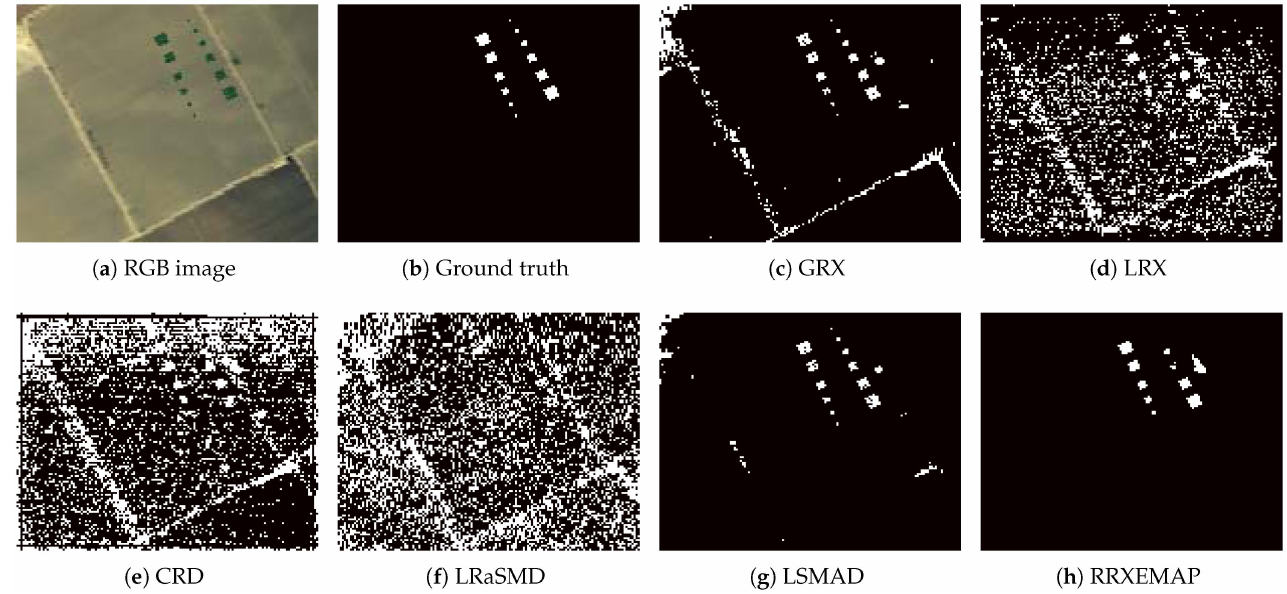
Figure 18. Color detection maps obtained by different algorithms for the Salinas-simulate